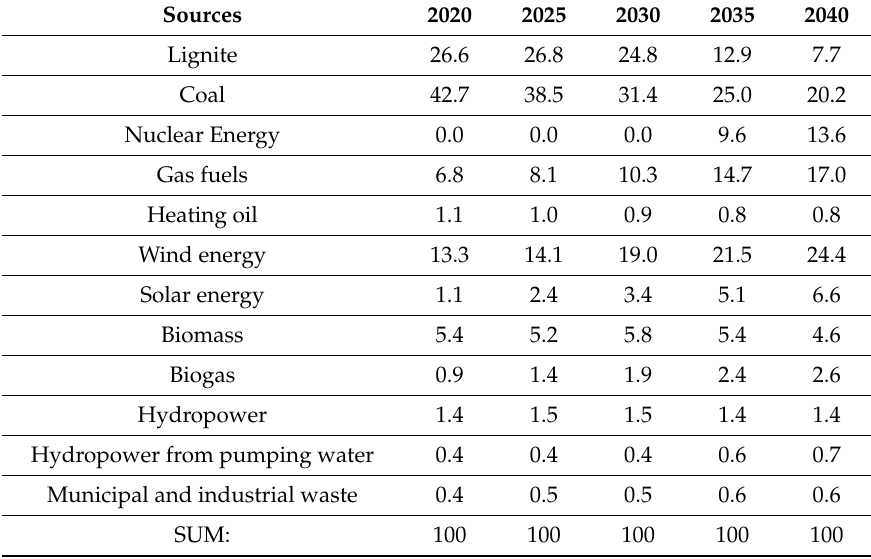
Table 1. Forecast of the net electricity production structure by source in 2020–2040.